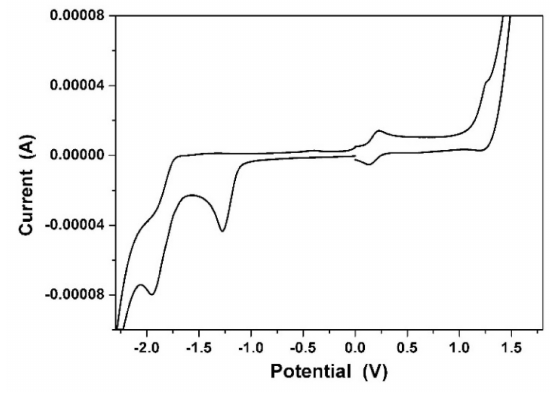
Figure 10. The cyclic voltammogram of 1 measured in dichloromethane solution with ferrocenium/ferrocene, at 200 mV/s. Table 3. Calculated and experimental parameters for 1 and 2